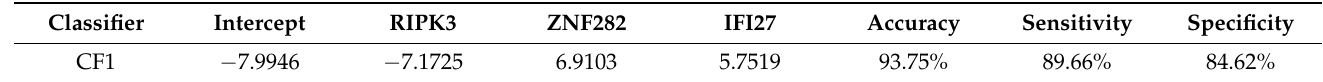
Table 10. GSE155454: Characteristics of the top-performing three-gene classifier CF1 for data of COVID-19 positives vs. negatives and healthy Table 9. GSE152641: Characteristics of the top-performing four-gene classifier. CF1 and CF2 are the first and second individual classifiers for data of COVID-19 patients vs. healthy controls.